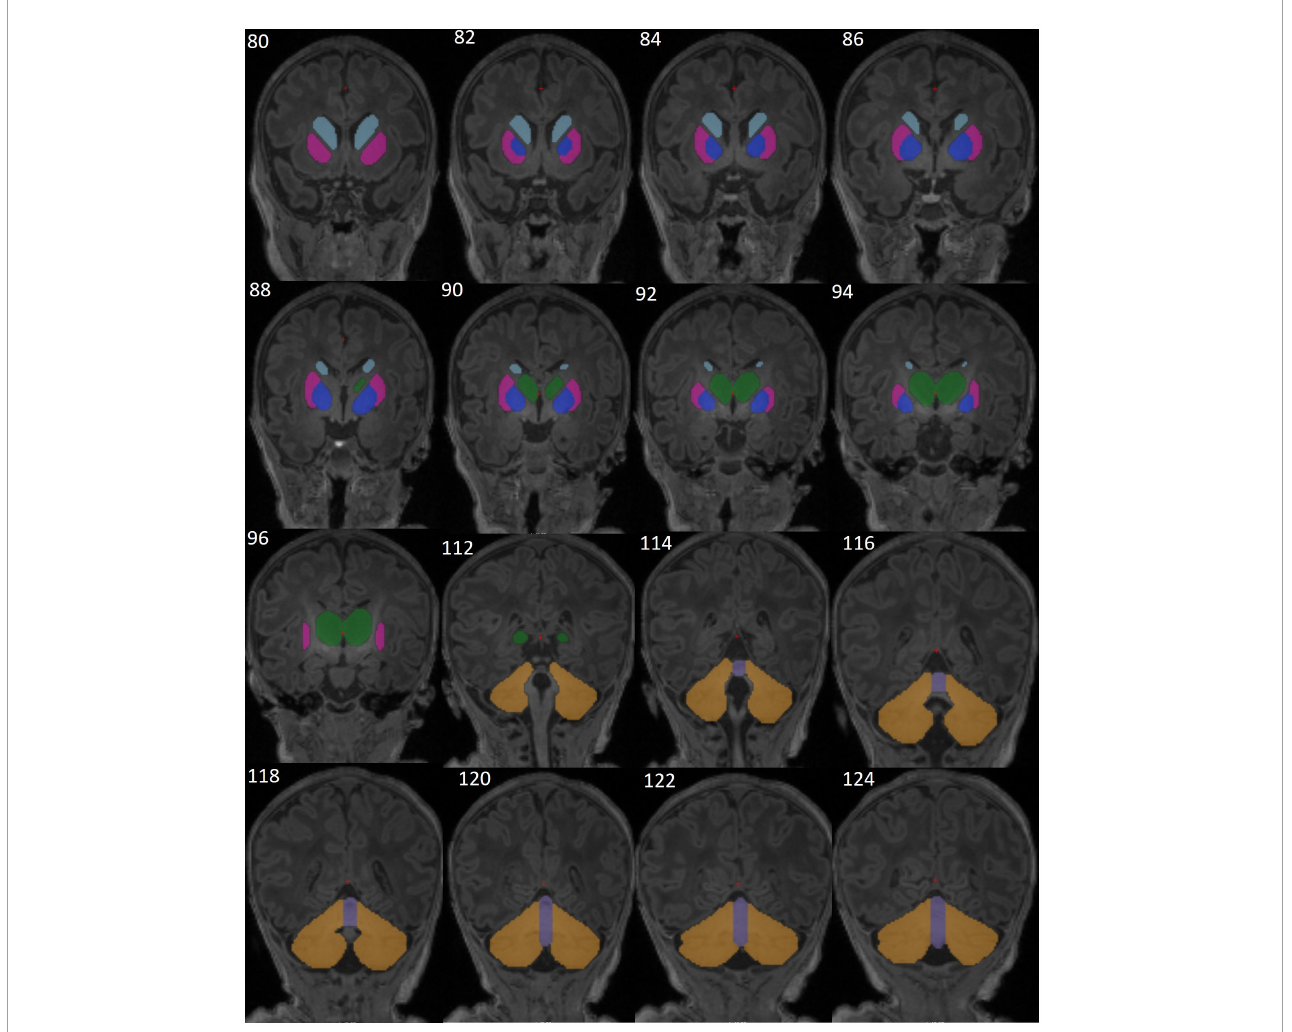
FIGURE2 Representative T1-weighted brain MR images from one neonate without HIV exposure or infection (HUU), showing the manually segmented structures of the basal ganglia [caudate (sky blue), putamen (magenta), pallidum (dark blue)], thalamus (green), cerebellar hemispheres (yellow), and cerebellar vermis (purple). Images are in coronal view (slices 80-96 and